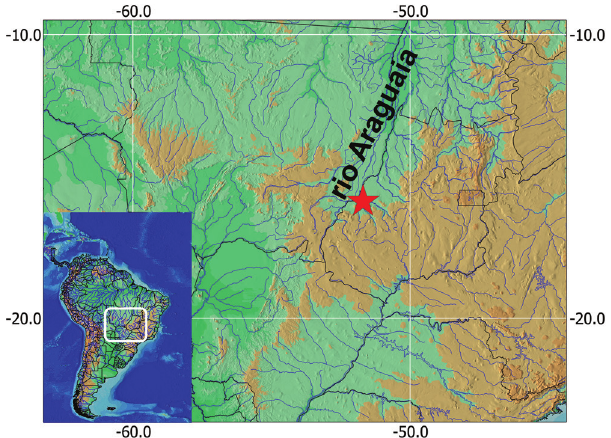
Fig. 6. Map showing the type locality (red star) of Corydoras eversi , an unnamed stream tributary to the rio Araguaia, Goiás State.